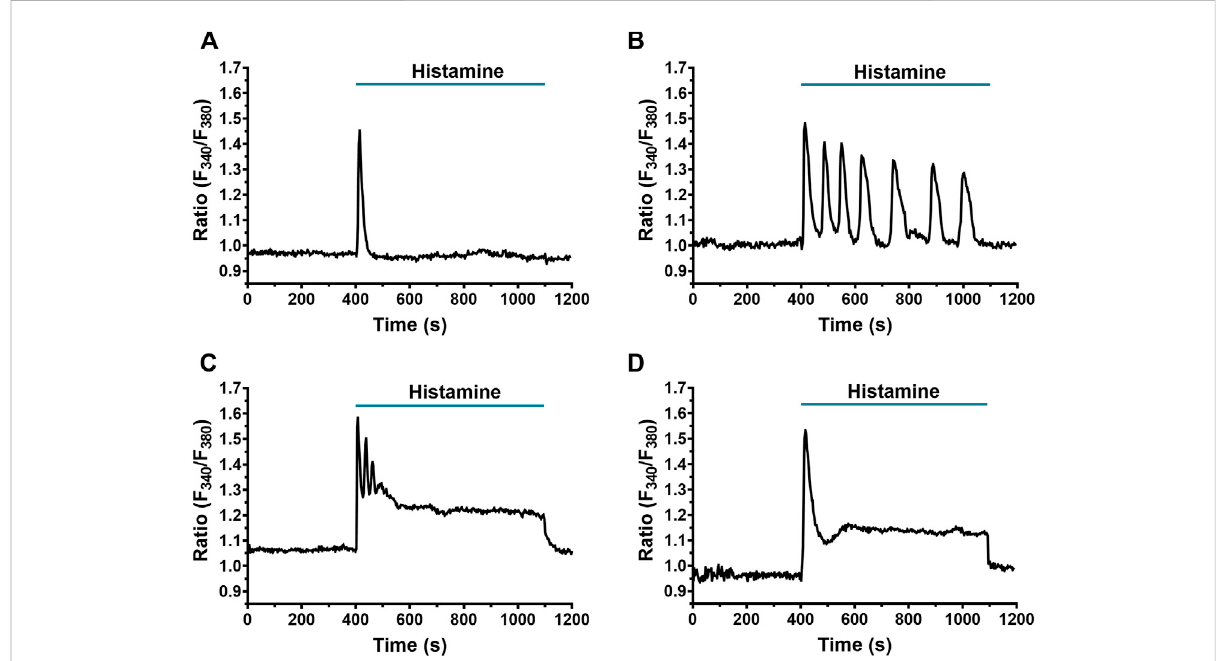
FIGURE 1 Heterogeneity in the Ca 2+ response elicited by histamine in WI-38 human lung fi broblasts. Application of histamine (300 μ M) elicited different Ca 2+ signal patterns in FURA-2 AM-loaded WI-38 human lung fi broblasts. The intracellular Ca 2+ signal consisted of (A) a rapid Ca 2+ peak (spike) (19.28% of cells analyzed) which could be followed by (B) Ca 2+ oscillations (64.70%) (peak-oscillations), (C) sustained plateau, superimposed by Ca 2+ oscillations (13.39%) (peak-plateau-oscillations) or (D) only a plateau (0.65%) (peak-plateau). In this and the following fi gures, histamine was added at the time indicated by the horizontal bar drawn over the Ca 2+ signal